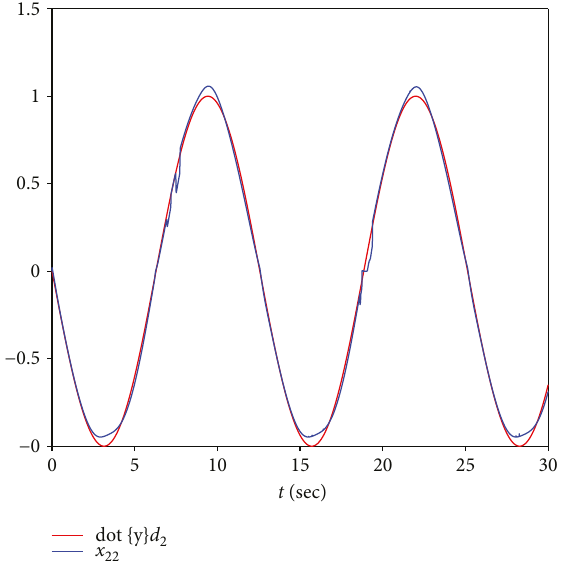
Figure 5: The time response of velocity tracking trajectory of Link 2.